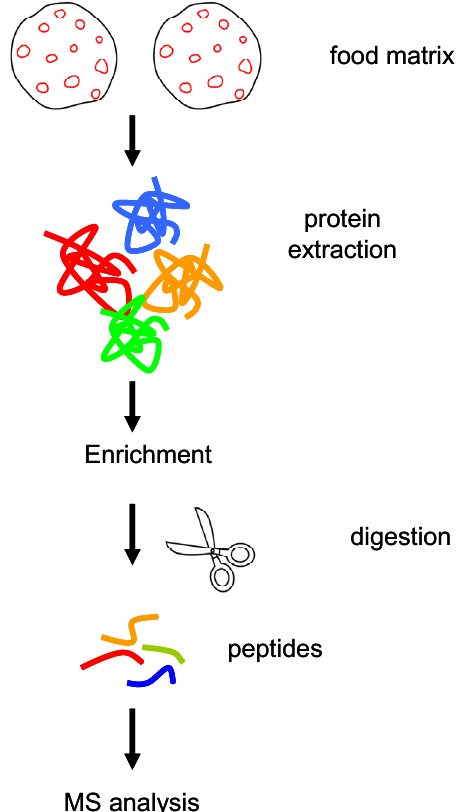
Figure 1. Workflow for sample preparation for mass spectrometry analysis. The different steps involve: protein extraction from the matrix, protein enrichment (optional), enzymatic (e.g., trypsin) digestion and MS analysis of the peptide mix either through shotgun (DDA) or targeted (SRM) proteomic